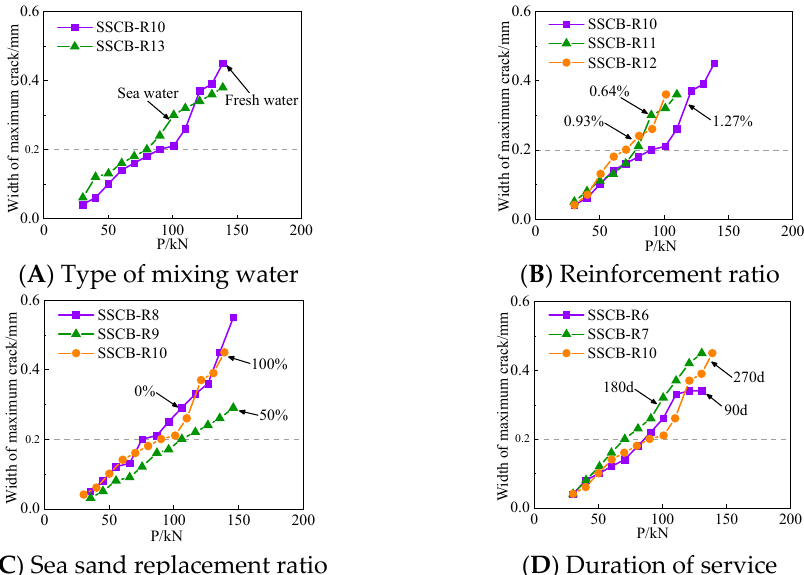
Figure 5. Curve of maximum crack width of specimen.